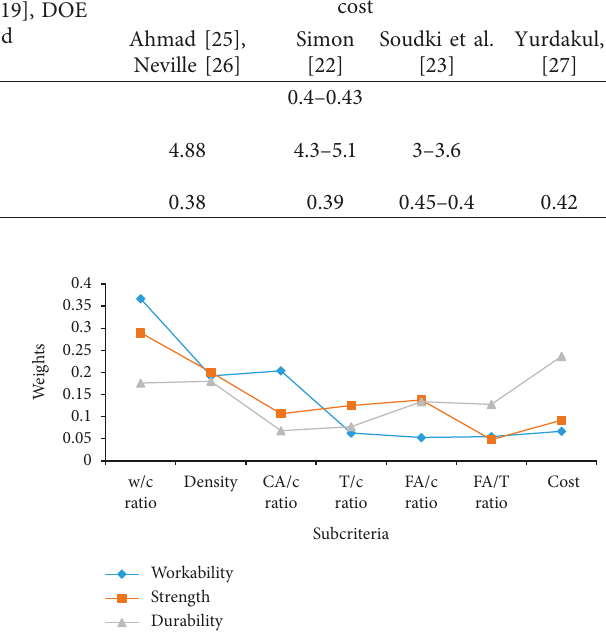
Figure 4: Weights of subcriteria with respect to objective criteria.